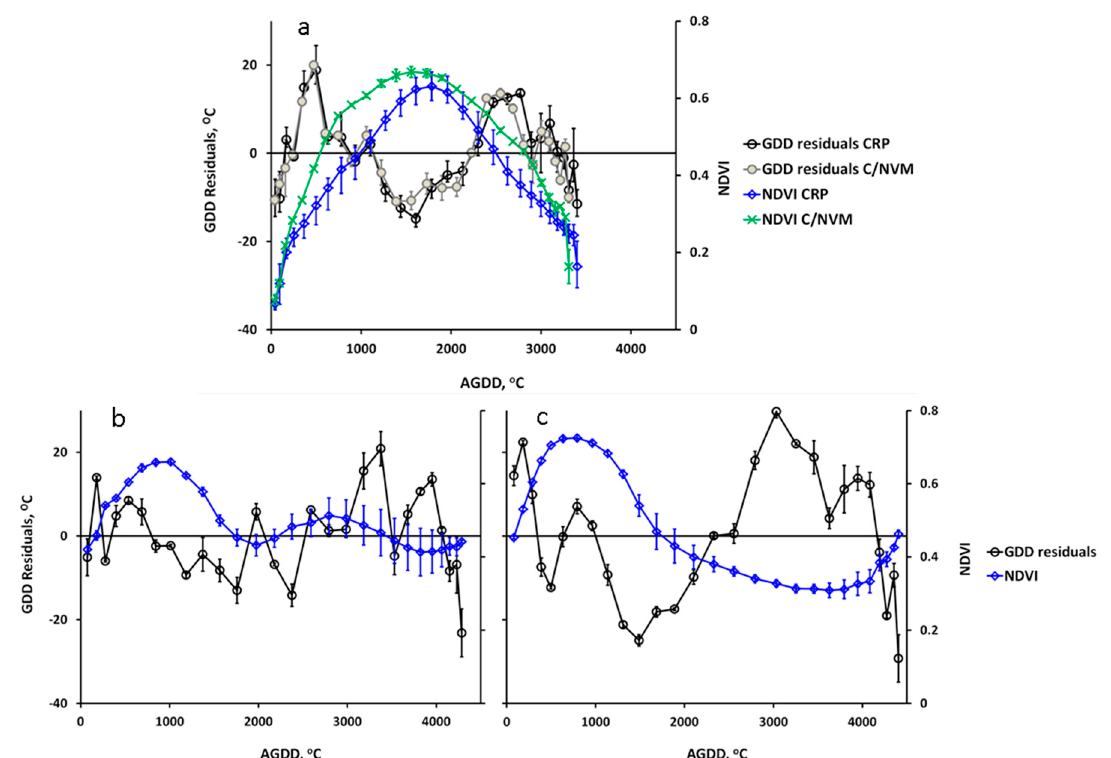
Figure 13. Average GDD residuals and NDVI with error bars displaying maxima and minima for sites at similar latitude. ( a ) Sites 35–37 and 39–41 in Kazakhstan (NDVI—blue triangles and GDD residuals—black diamonds) and sites 34 and 42 in Kazakhstan (NDVI—green crosses and GDD residuals—gray circles); and ( b , c ) sites 1 and 2 in Russia (NDVI—blue diamonds and GDD residuals—black circles) for selected bimodal cropland pattern years and unimodal years, respectively.